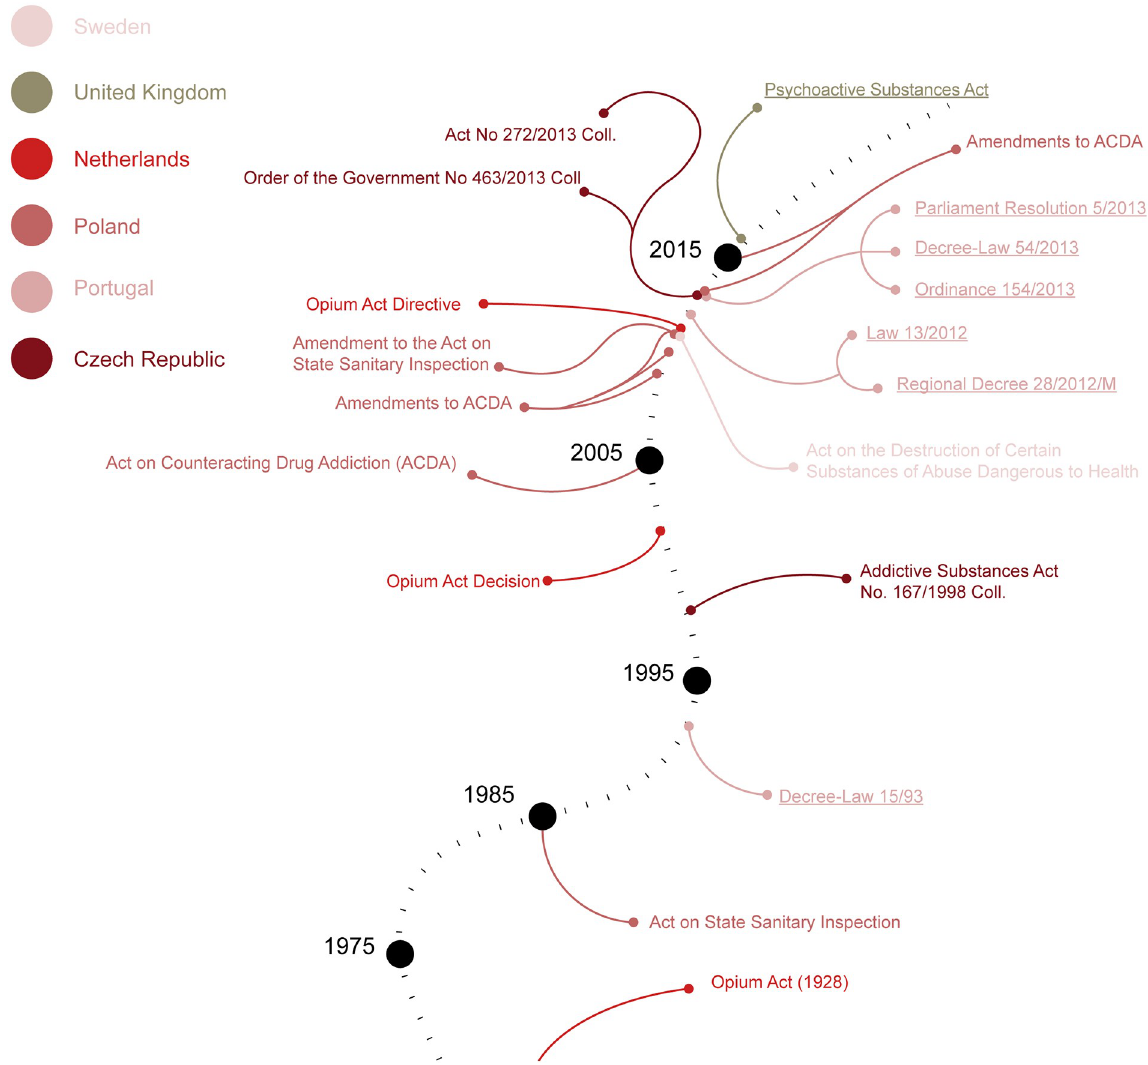
Fig 2. A chronological overview of the legislation that pertains to Novel Psychoactive Substances in the jurisdictions under study. Legislation that is specifically designed for NPS is